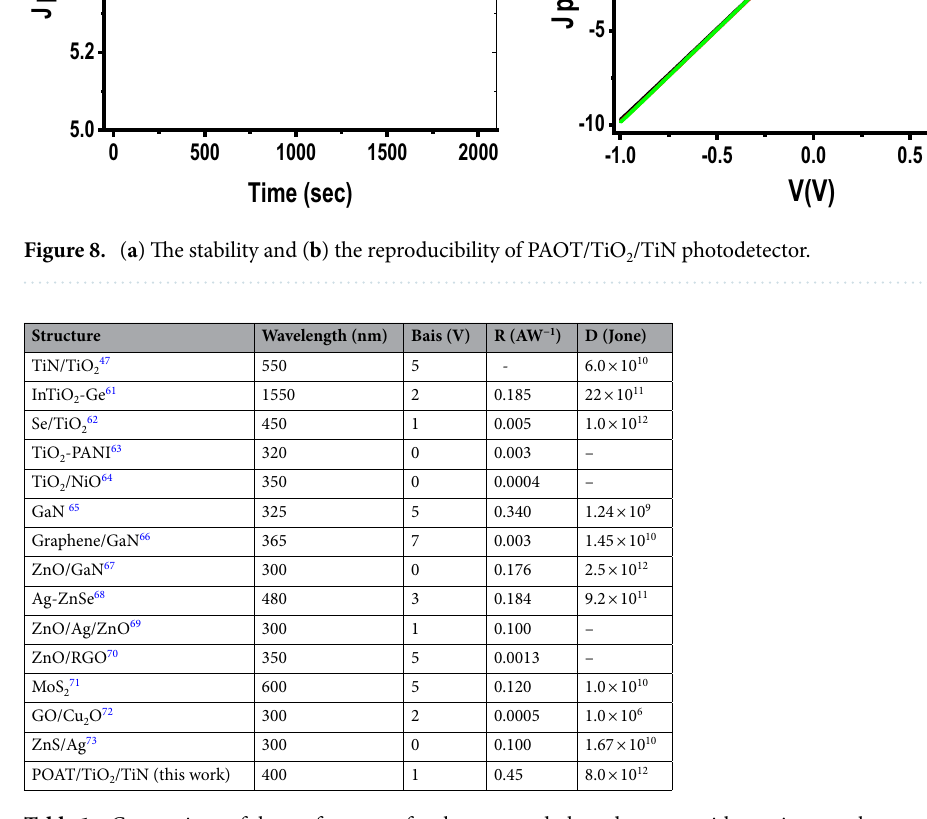
Table 1. Comparison of the performance for the prepared photodetectors with previous works.